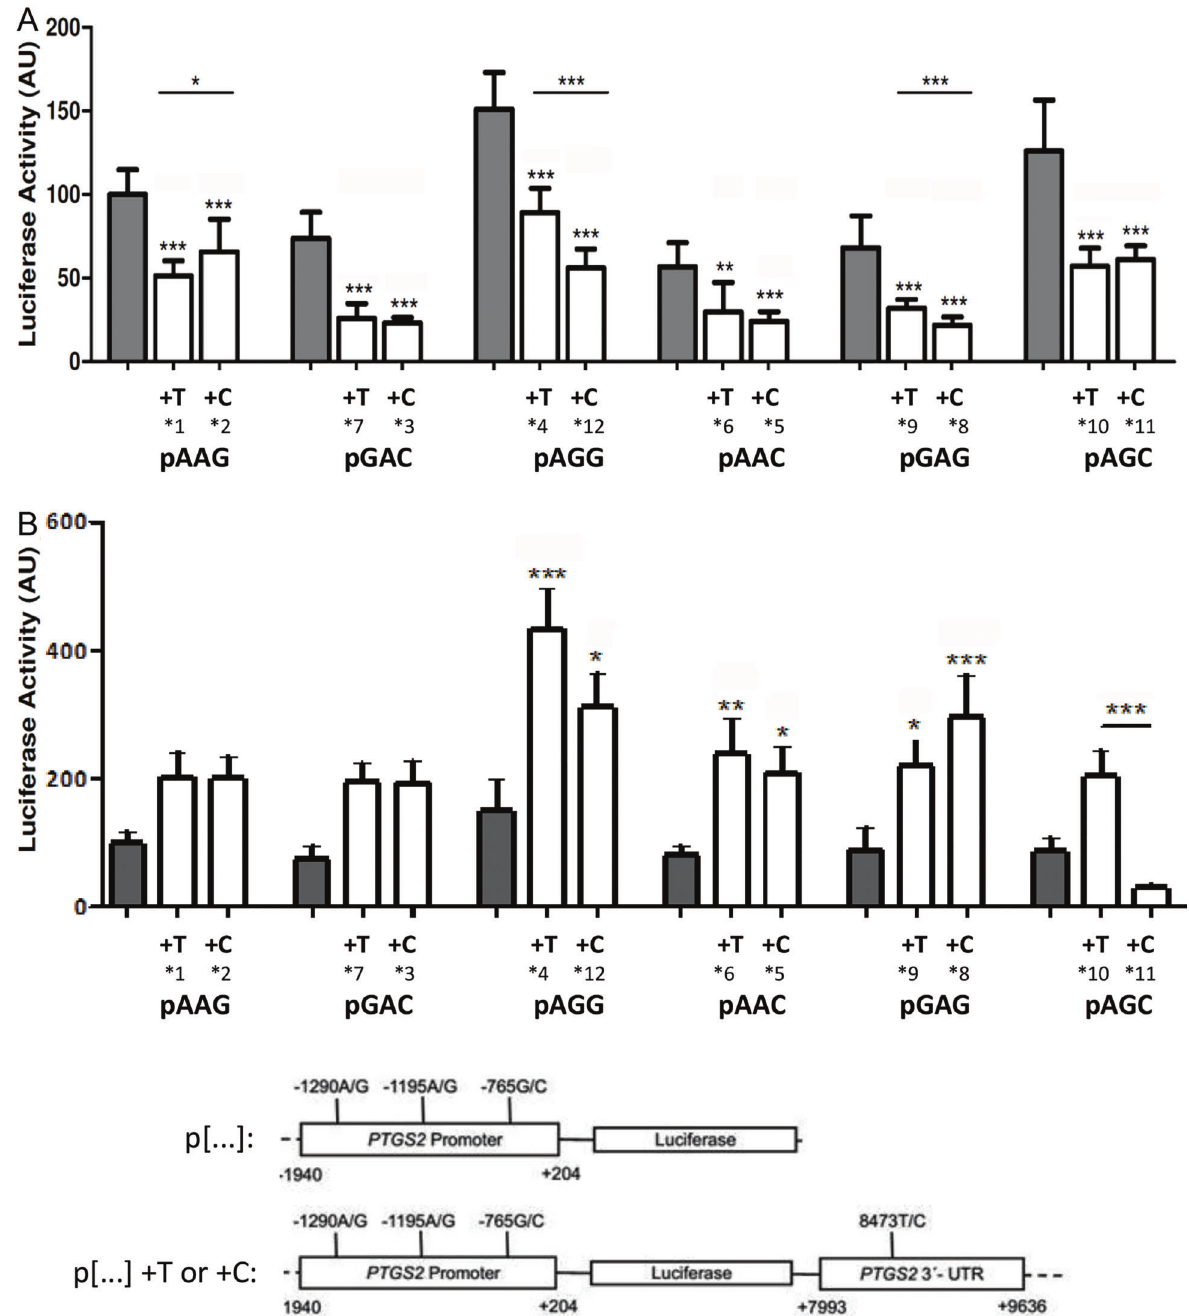
Figure 2. Luciferase activity of constructs containing the promoter region alone or in combination with the 3 0 -UTR ( rs5275 T or C ) of the PTGS2 gene in MCF-7 cells ( A ) or in HEK293FTcells ( B ). Data are reported as the fold variation of luciferase activity in relation to pAAG, and are the means ± SD from at least 2 independent transfection experiments, comprising 12 replicates. Cells were cotransfected with pGR-TK to normalize transfection ef fi ciency. Statistical analyses were performed within each haplotype triad, i.e. comparing the results between constructs enclosing both PR and 3 0 -UTR sequences (containing either rs5275 T or C ), as well as comparing each full haplotype to their respective parental PR sequence. *P o 0.05, **P o 0.001, ***P o 0.0001 (Kruskal-Wallis test with Dunn ’ s